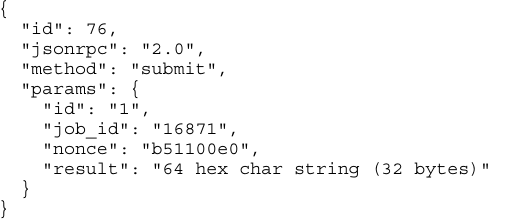
header using the found nonce is returned as result .